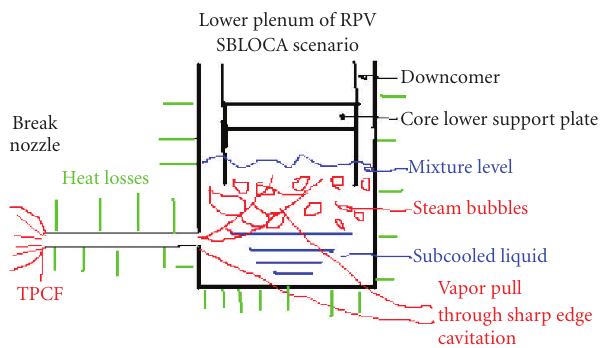
Figure 7: Schematic representation of a two-phase flow condition in a reactor pressure vessel of a facility during an